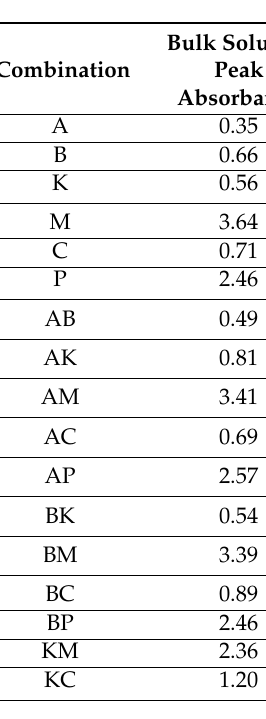
Figure 6. UV-Vis spectra of the six constituent dyes adsorbed to transparent TiO 2 anodes (Solaronix T/SP paste).